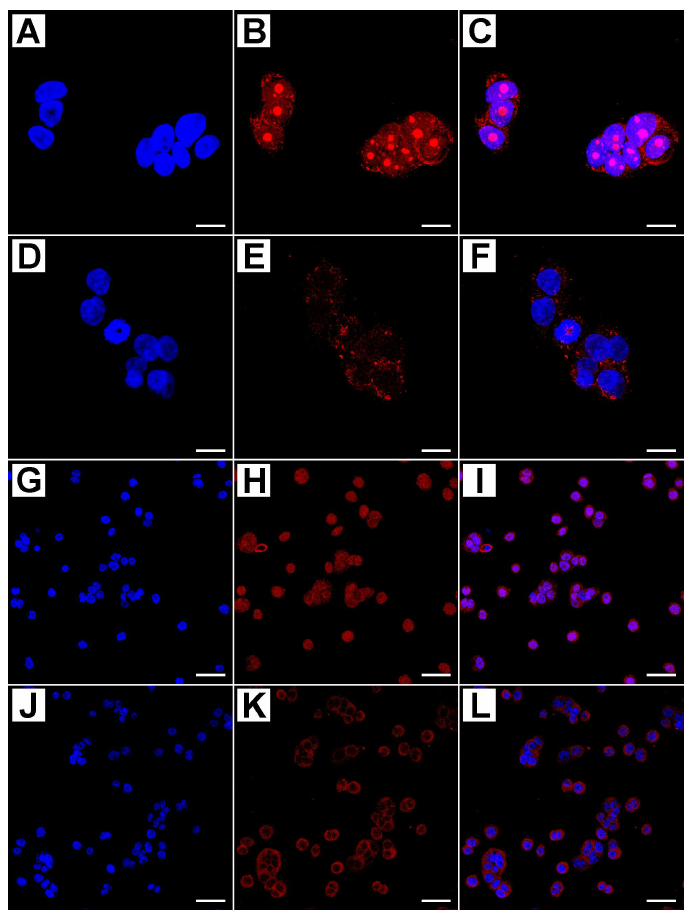
Figure 6. Confocal analysis of NRF-2 and NF-κB proteins in treated and untreated cells with graded concentrations of metformin (Blue: DAPI; Red: NRF-2, and NF-κB; ( C , F , I , L ): merge). NRF-2 clearly concentrations of metformin (Blue: DAPI; Red: NRF-2, and NF- κ B; ( C , F , I , L ): merge). NRF-2